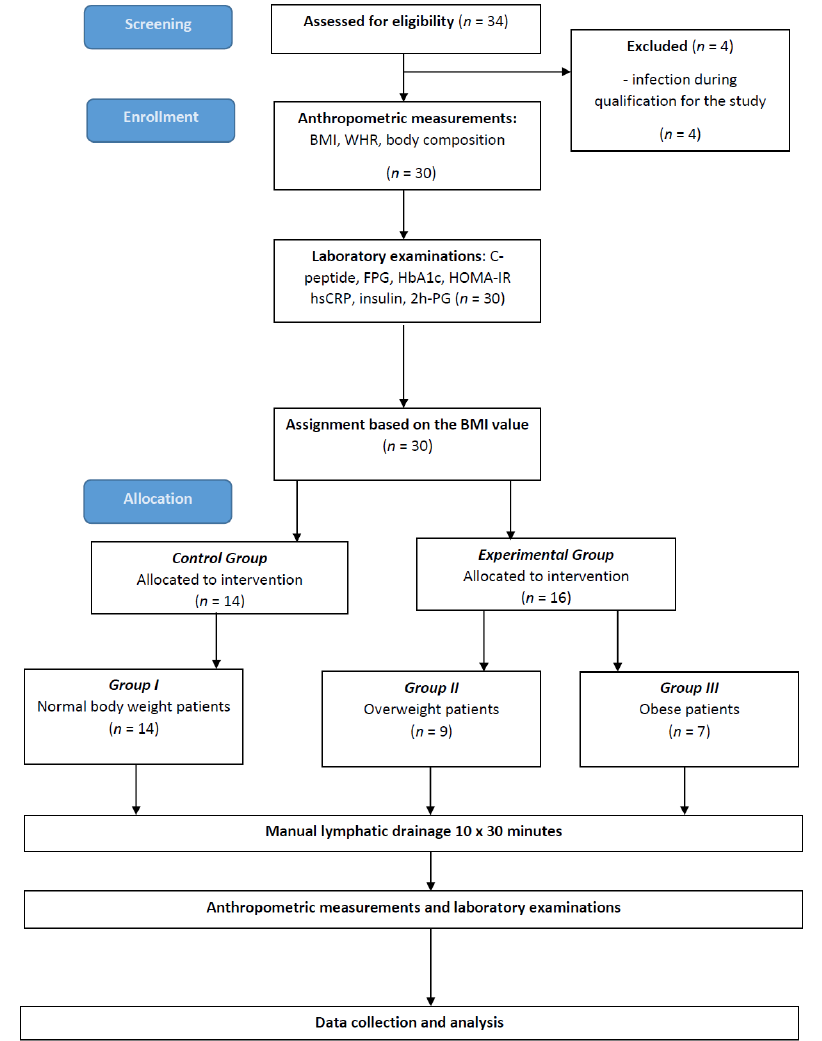
Figure 1. Study flow chart. Abbreviations: BMI, body mass index; FPG, fasting plasma glucose; HbA1c, glycated hemoglobin; HOMA-IR, homeostatic model assessment–insulin resistance; hsCRP, high-sensitivity C-reactive protein; WHR, waist–hip ratio; 2h-PG, 2h-post-load